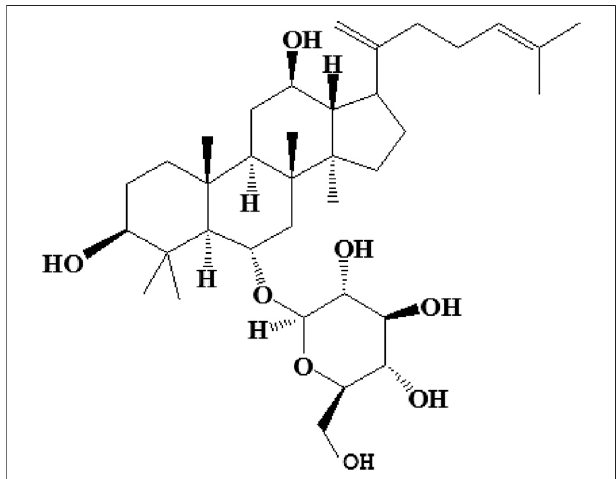
FIGURE 1 | The chemical structure of ginsenoside